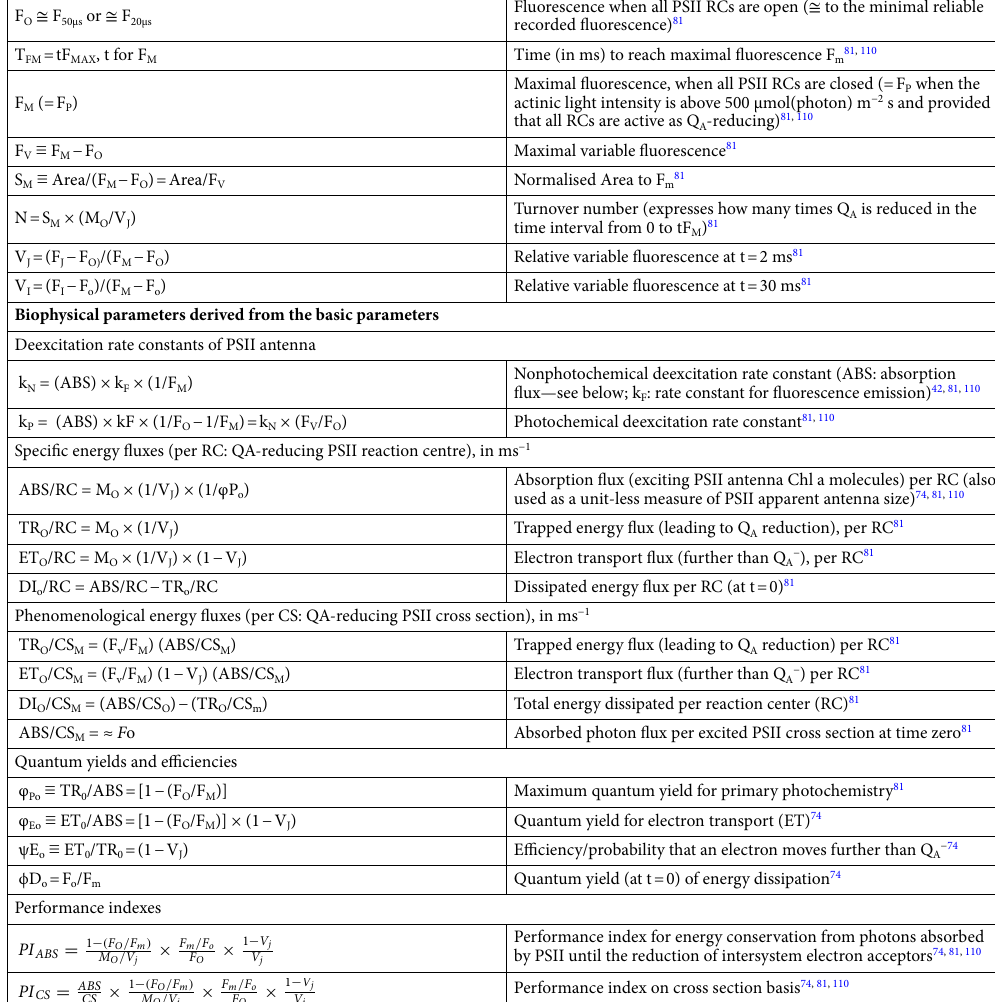
Table 2. Abbreviations, formulas, and definitions of the JIP-test